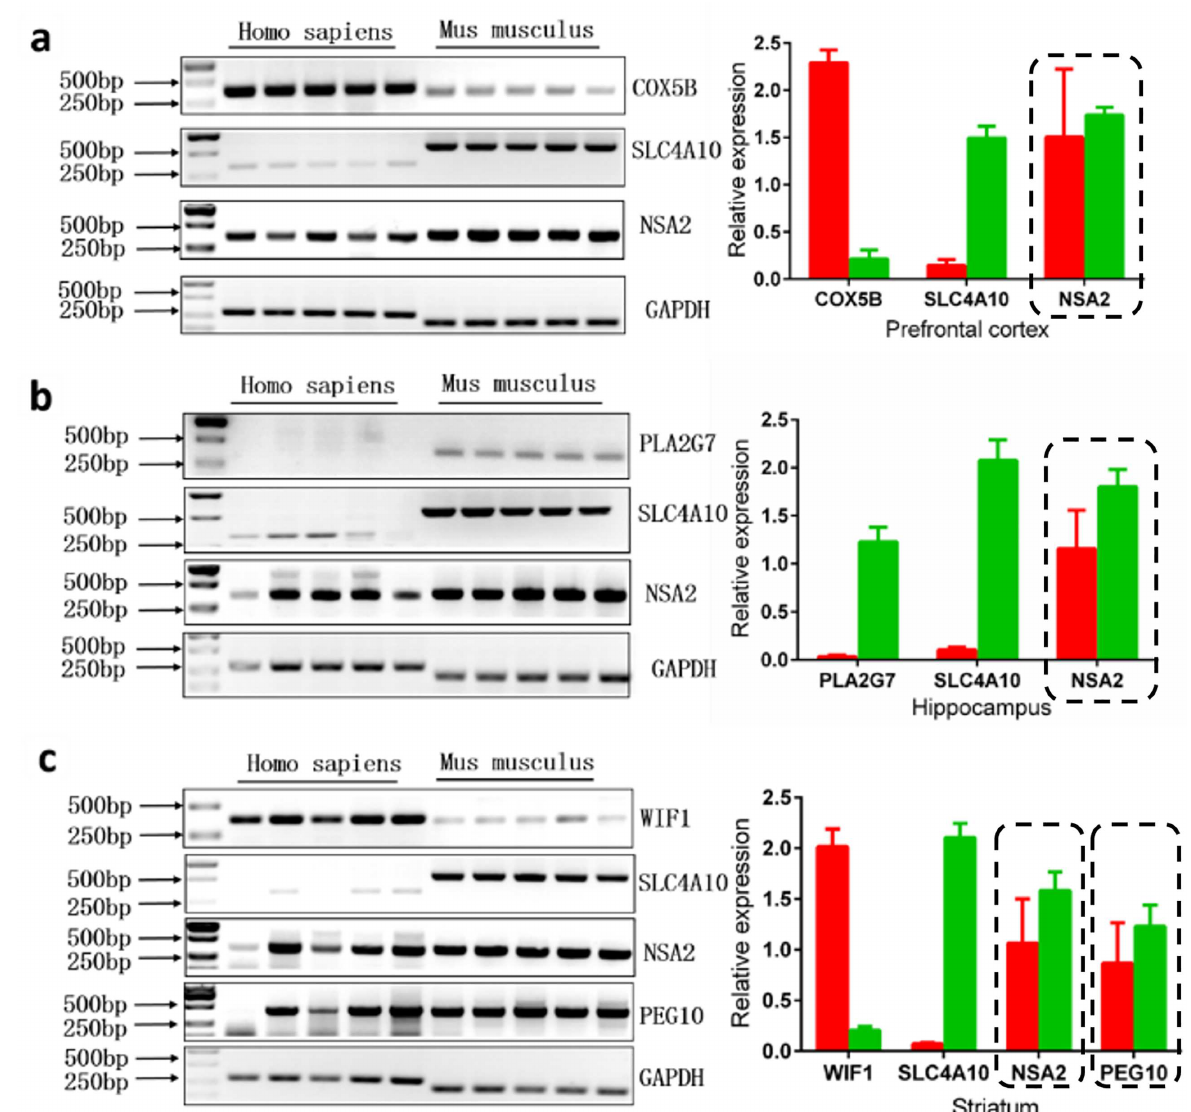
Fig 4. Confirmation of Affymetrixmicroarraydata by RT-PCR. GAPDH , a housekeeping gene, was used to normalize gene expression in human and mouse (a) PFC, (b) HIP and (c) STR. Genes that are predicted by miacroarraydata but not verified by RT-PCR are highlighted using dashed boxes. The backgroundand band colors were reversed. The average relative densitometry values were analyzedusing Image J software. Data are expressedas mean ± SD. Red bars represent human and green bars